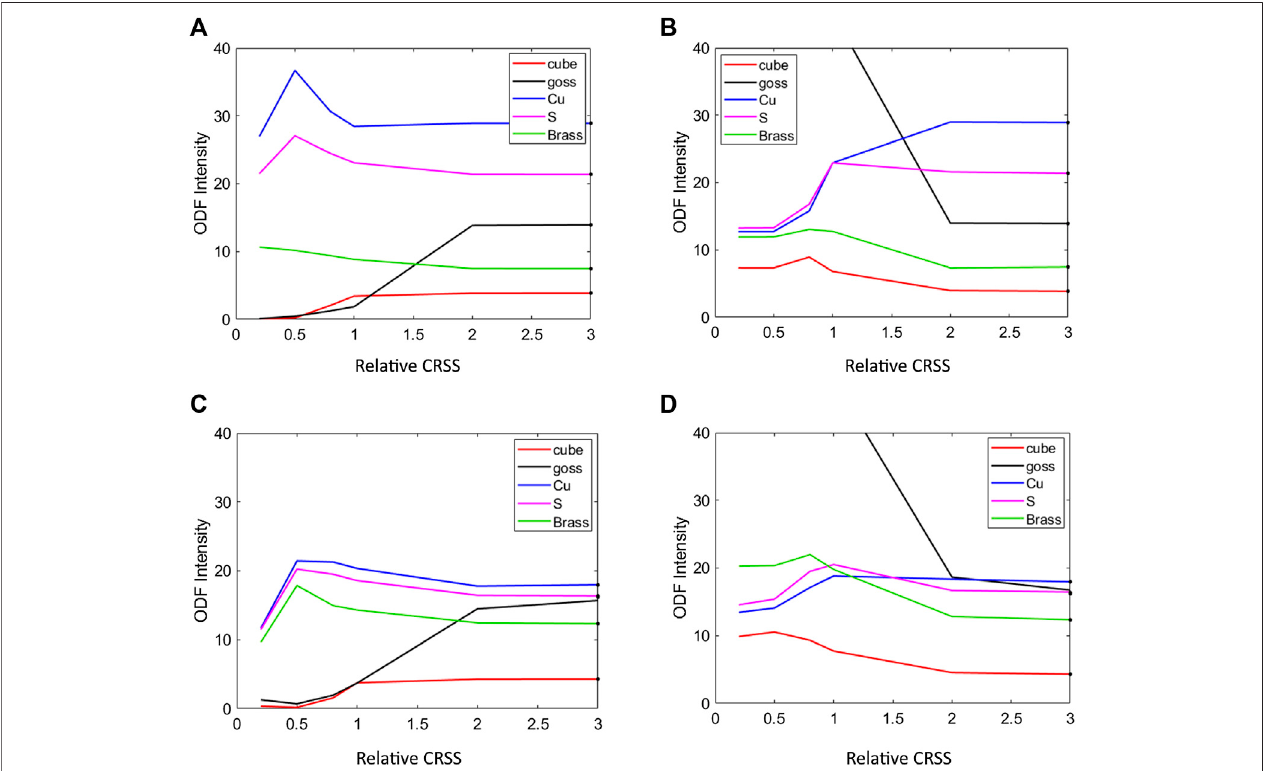
FIGURE 7 | Effect of the strain rate sensitivity and the activation of the non-octahedral slip systems on the texture component intensity prediction in the Alamelmodel. (A) m (cid:1) 0.1, octahedral slip + { 110 } 〈 110 〉 (B) m (cid:1) 0.1, octahedral slip + { 112 } 〈 110 〉 (C) m (cid:1) 0.25, octahedral slip + { 110 } 〈 110 〉 (D) m (cid:1) 0.25, octahedral slip + { 112 } 〈 110 〉 .